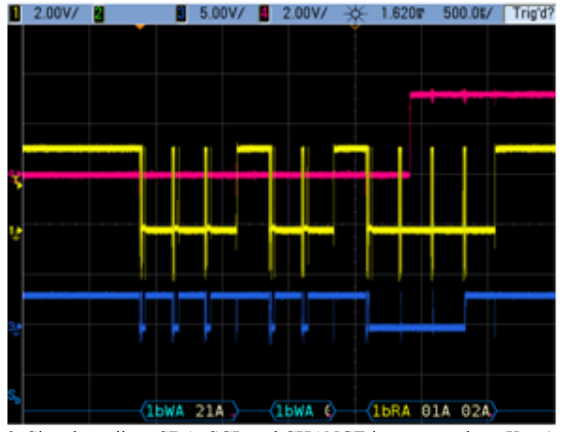
Fig. 8. Signals on lines SDA, SCL and CHANGE in case touch on Key